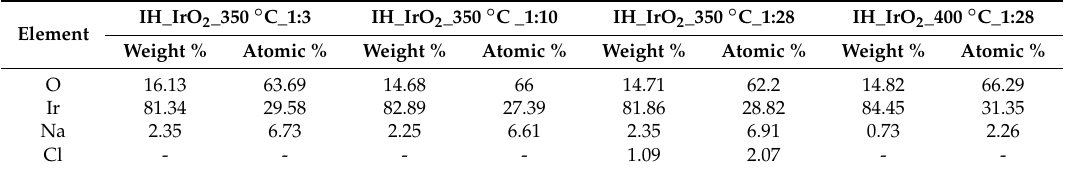
Table 3. Energy dispersive spectroscopy (EDS) analysis for the elemental composition of the in-house IrO 2